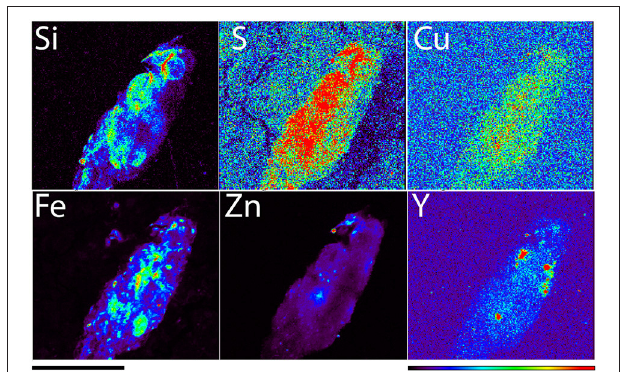
FIGURE 3 | A detail of rat liver tissue elemental map obtained with 300 nanometer spot size (station 2ID-E), X-ray energy 21 keV. Scale bar − 100 microns, color bar indicates elemental quantity as represented by false colors, from black (no signal) to red (highest signal). Signal maxima in micrograms per cm square for different elements were: 125 for Si, 5.45 for S, 0.199 for Cu, 50.9 for Fe, 23.7 for Zn, and 0.635 for